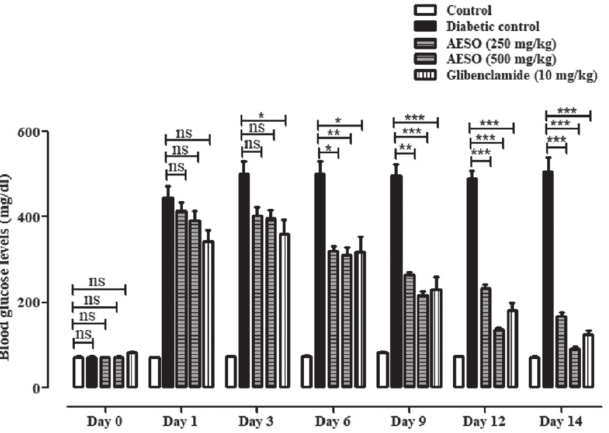
FIGURE 2 - Effect of aqueous extract of Sigesbeckia orientalis on blood glucose levels in control and experimental groups at different days of treatment. Comparison was made between glucose levels in blood samples of alloxan-induced diabetic rats and AESO and glibenclamide treated animals. At day 0 and 1 no significant change in blood glucose levels was observed in any treatment group. Blood glucose levels in normal healthy rats remained significantly lower throughout the study. Where ns = non-significant, * = p < 0.25, ** = p < 0.01, *** = p < 0.001 and Diabetic control = Alloxan-induced diabetic rats (150 mg/kg)